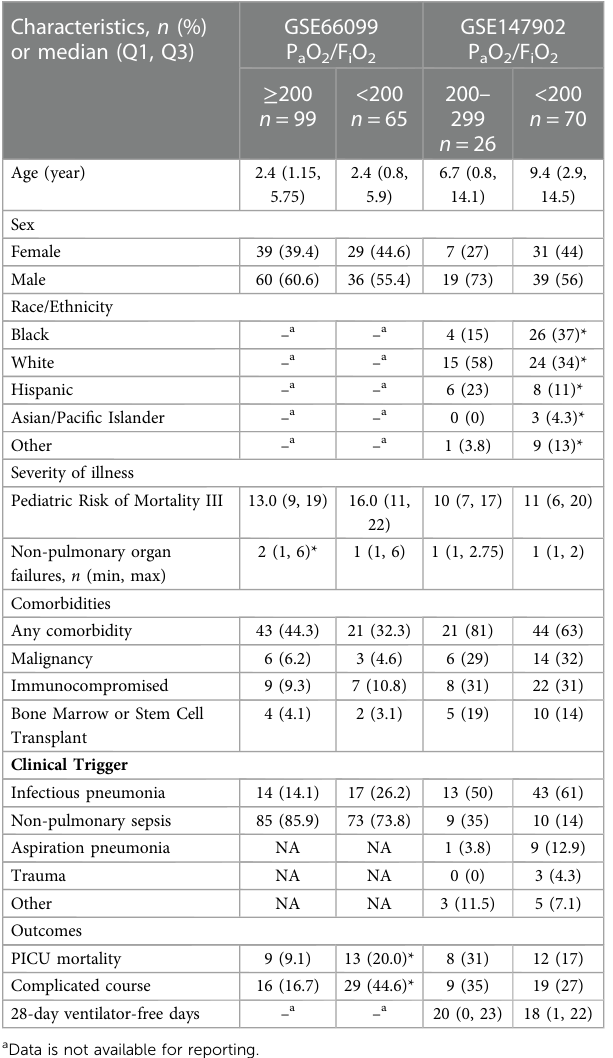
TABLE 1 Demographic and clinical characteristics of cohort participants. Characteristics, n (%) or median (Q1, Q3)